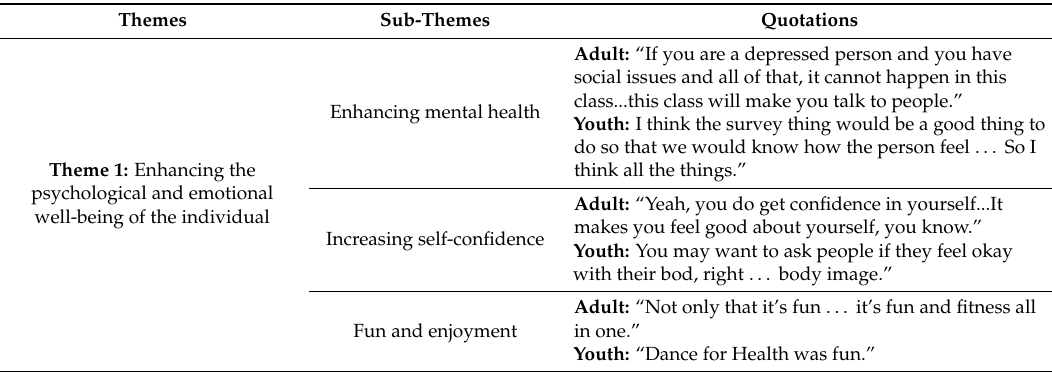
Table 3. Themes and Quotations: (N =